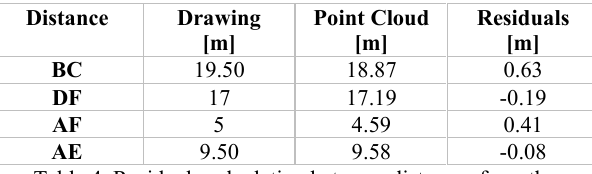
Table 4. Residuals calculation between distances from the drawing and the point cloud of Les